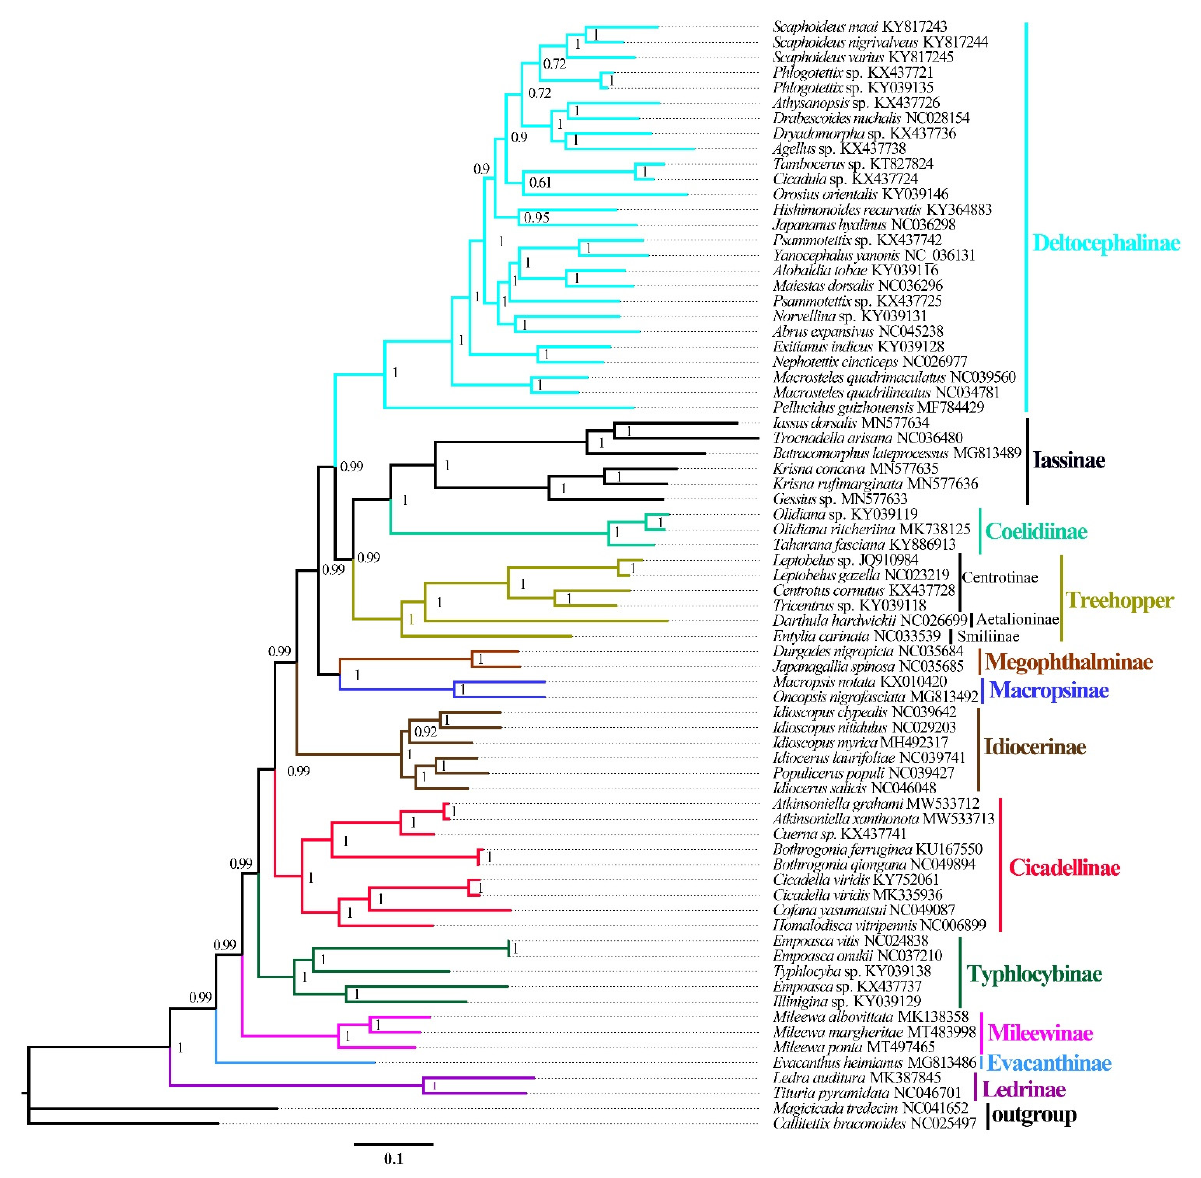
Figure 8. Phylogenetic trees inferred by Bayesian inference (BI) based on the amino acids (AA). Numbers on each node correspond to the Bayesian posterior probability (PP) for 100 million generations.